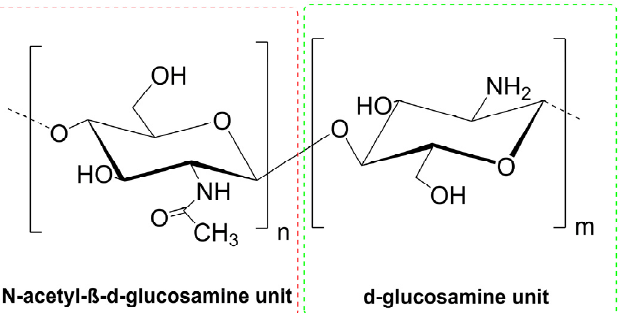
Figure 1. The structure of chitin/chitosan composed of N-acetylglucosamine and D-glucosamine units: m < n chitin, m > n chitosan. units: m < n chitin, m > n